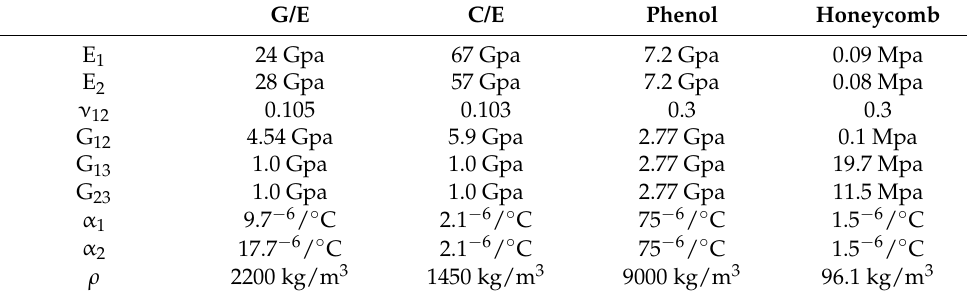
Table 1. Material properties of the smart-skin antenna structure [4].